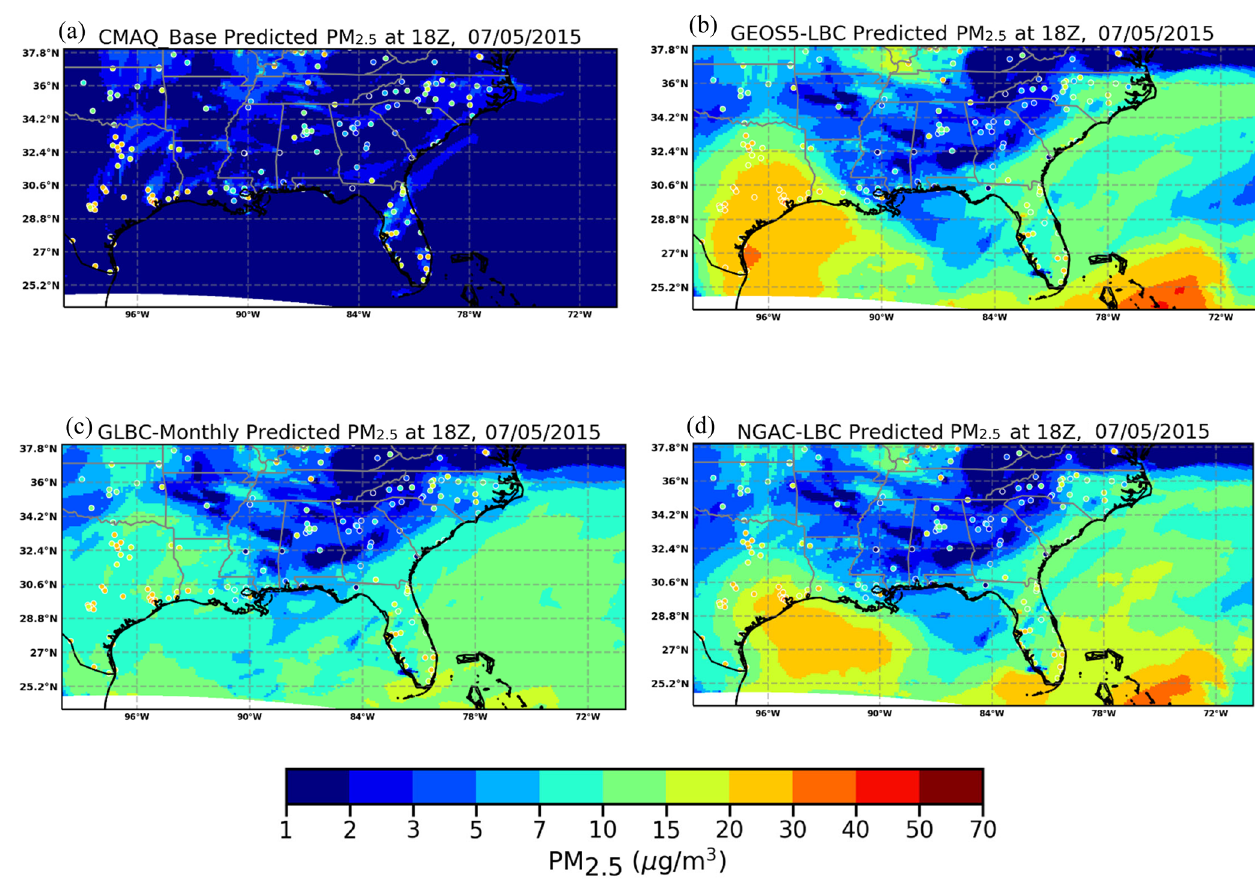
Figure 5. Same as Fig. 4 but for 5 July 2015. Please note that the dates in this figure are given in the format of month day year